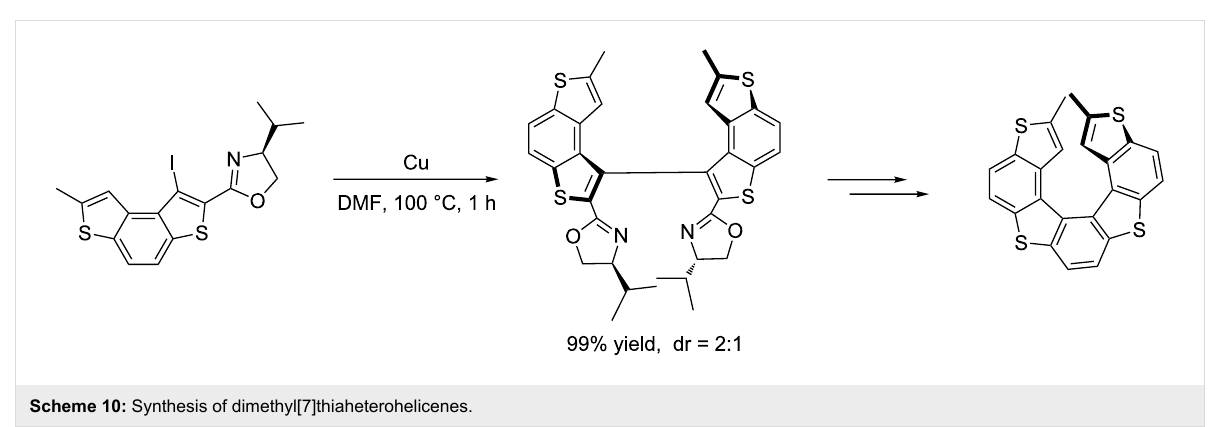
Scheme 10: Synthesis of dimethyl[7]thiaheterohelicenes.